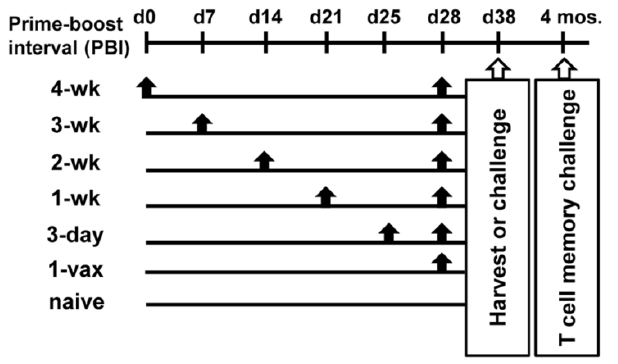
Figure 1. Schematic of prime-boost interval schedule. Six different vaccine regimens were used in this study: in each experiment five groups of mice ( n = 5–10/group) received a prime vaccination with HPV16 VRP, followed by boosting with the same vaccine after different intervals (4 weeks, 3 weeks, 2 weeks, 1 week, and 3 days, denoted by black arrows). One group received only one vaccination without boosting (1-vax). One group did not receive any vaccinations (naïve mice). Vaccination schedules were planned so that all mice received their final vaccination on the same day. In vitro assays were performed on splenocytes isolated ten days after final injection, or mice were challenged with C3.43 tumors to assess effector T cell response. To analyze memory T cell recall responses, mice were challenged 4 months after the last vaccination without any intervening treatment.